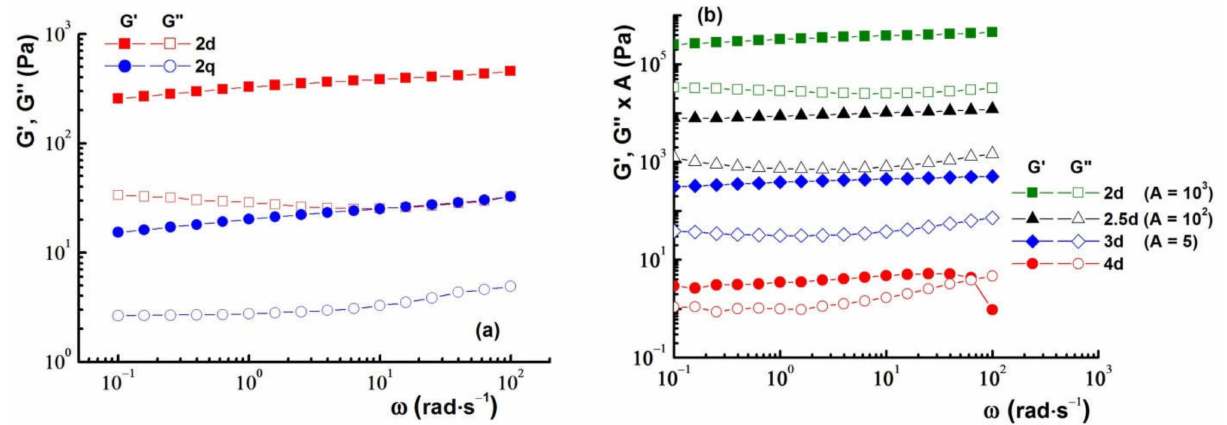
Figure 7. Variation of G (cid:48) and G (cid:48)(cid:48) as a function of ω for the samples with different ( a ) dilutions of the starting system and ( b ) NH 2 /CHO ratios at 37 ◦ C and amplitude strain of